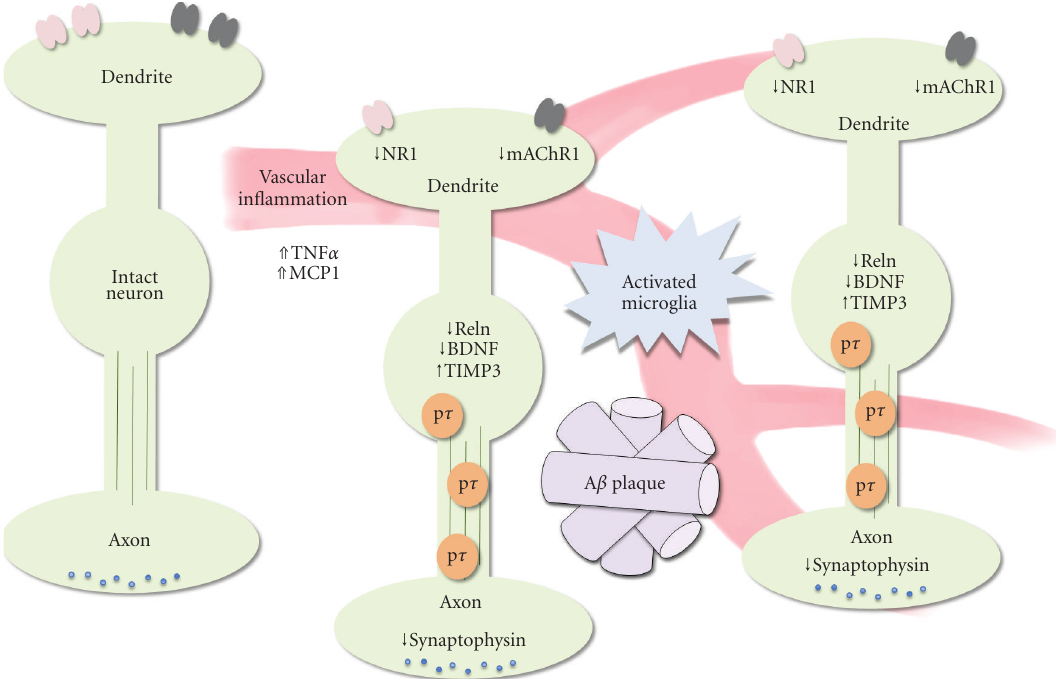
Figure 2: Microenvironmental changes interact with intrinsic cellular alterations to promote the selective vulnerability of entorhinal layer II neurons in aging and AD. Neurons located further away from plaques are likely to maintain a greater degree of structural and functional integrity in AD, while neurons situated close to plaques and in the vicinity of the vasculature are exposed to elevated levels of inflammatory cytokines such as tumor-necrosis factor-alpha (TNF alpha) and monocyte chemoattractant protein 1 (MCP1). Proinflammatory alterations in the local microenvironment, together with intrinsic changes in neuronal reelin (Reln), brain-derived neurotrophic factor (BDNF), and tissue inhibitor of metalloproteinase 3 (TIMP3) expression, could potentially impair synaptic function. This impairment would alter signal propagation both locally, through reductions in NMDA NR1 subunit and muscarinic acetylcholine receptor M1 (mAChR1) expression, and downstream in the hippocampus, through reductions in synaptophysin expression in the terminal fields for layer II entorhinal